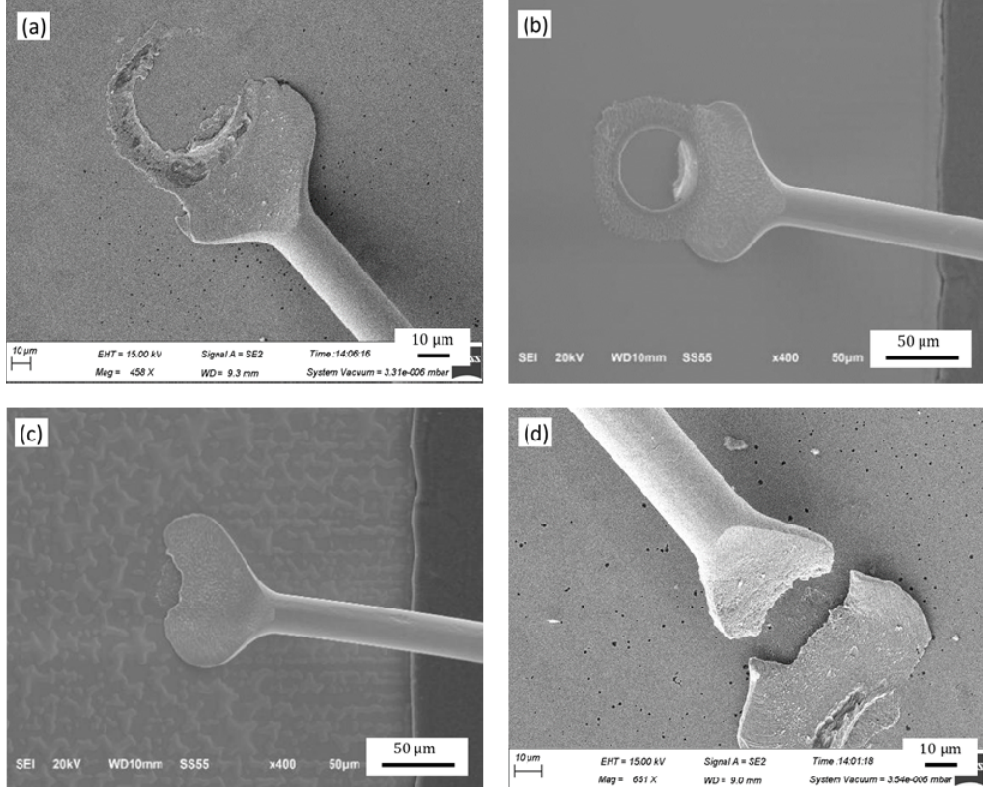
Figure 14. The topography of the second bonded points with WFAs of: ( a ) 8°; ( b ) 4°; ( c ) 11°; ( d ) second bonded point fracture due to the small WFA.